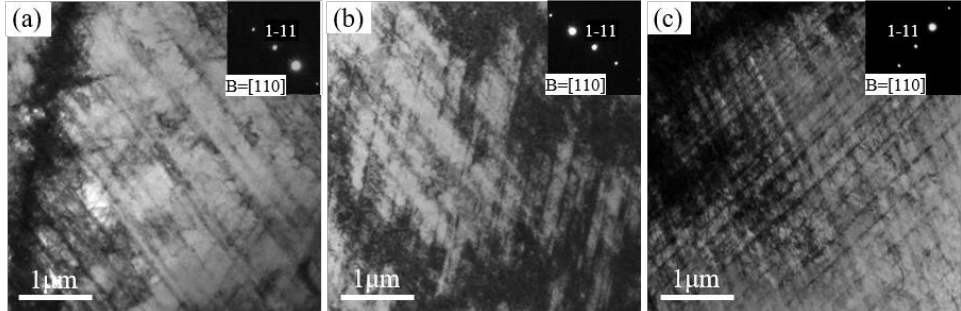
Figure 7. TEM images of the experimental steel after fracture at different annealing temperatures. ( a ) 900 °C; ( b ) 950 °C; and ( c ) 1000 °C ( a ) 900 ◦ C; ( b ) 950 ◦ C; and ( c ) 1000 ◦